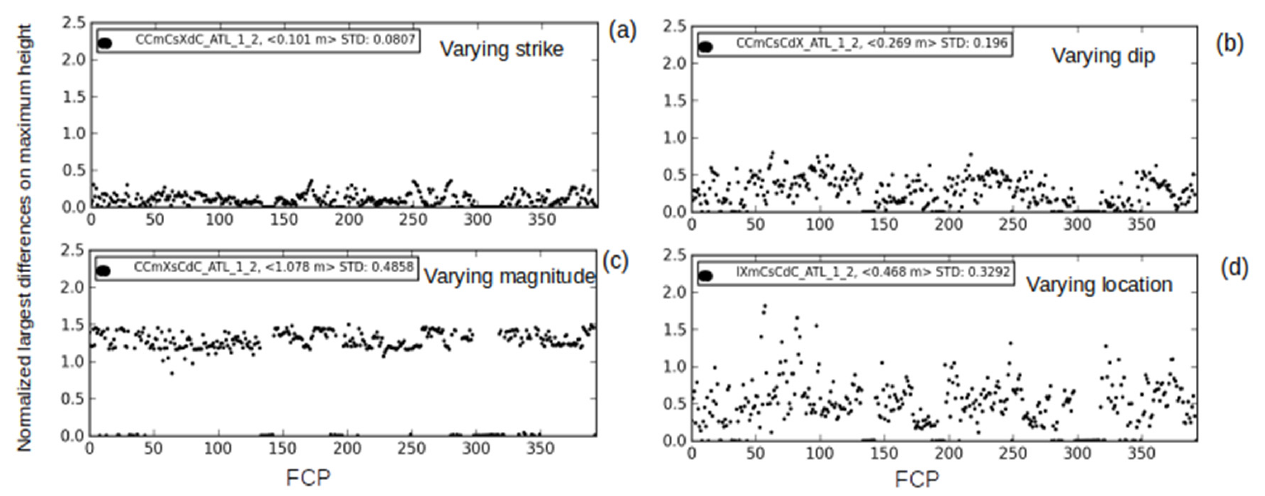
Figure 5. Black dots indicate normalized largest differences of maximum height in FCPs for cases corresponding to scenarios where one source parameter takes different values in the range defined in this study from the scenario of reference: varying ( a ) strike, ( b ) dip, ( c ) magnitude and ( d ) location.